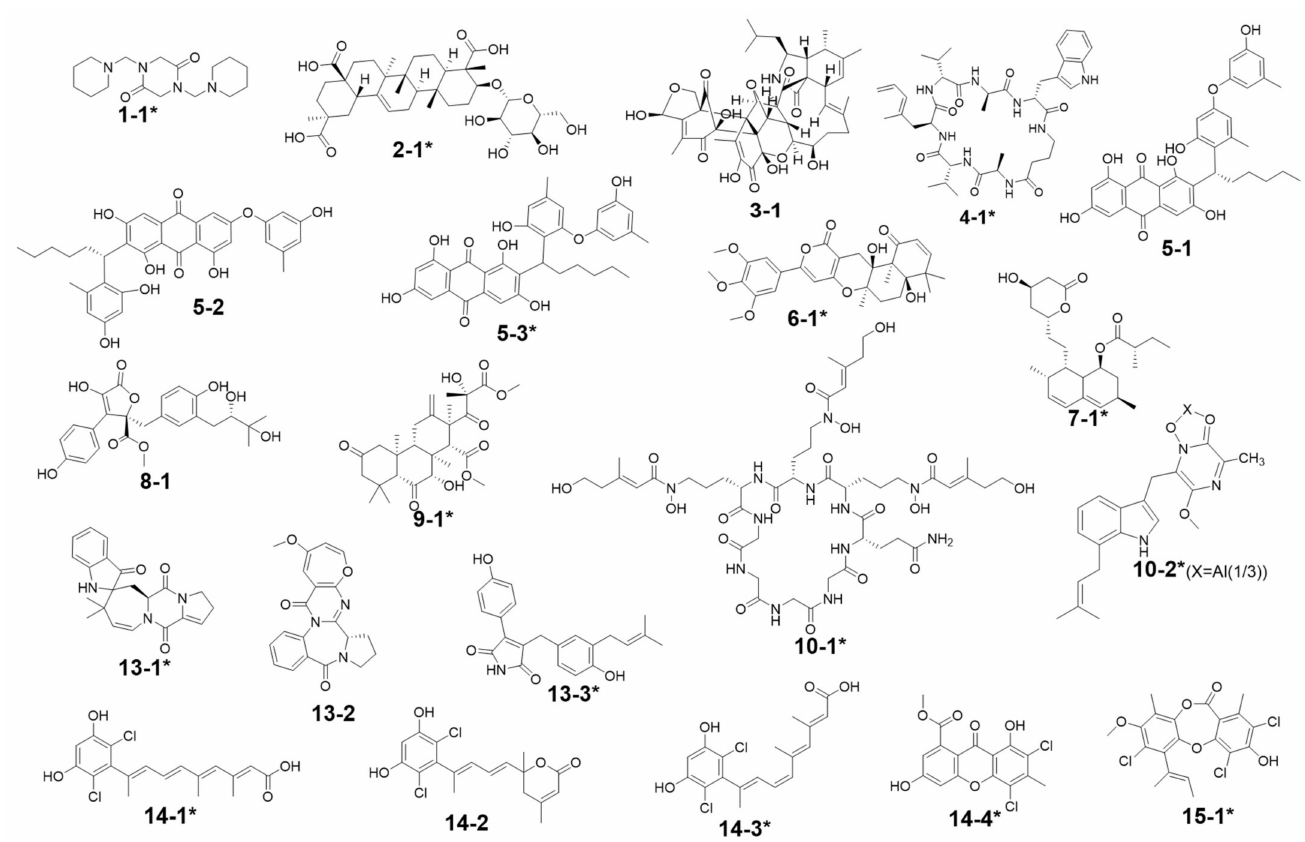
Figure 8. Annotated compound structures for the peaks 1–15. The asterisks (*) mark hits from databases with relatively higher reliability based on their similarities, including not only molecular weights, but also at least one of the following characteristics like GNPS MS 2 similarity, UV features, isotopic patterns (for chlorinated compounds), and taxonomy, to the featured peaks. Compounds 10 - 1 and 10 - 2 represent two alternative annotations for peak 10 (see Table 3 for further data on each of these annotations). This terminology also applies for the other base compound